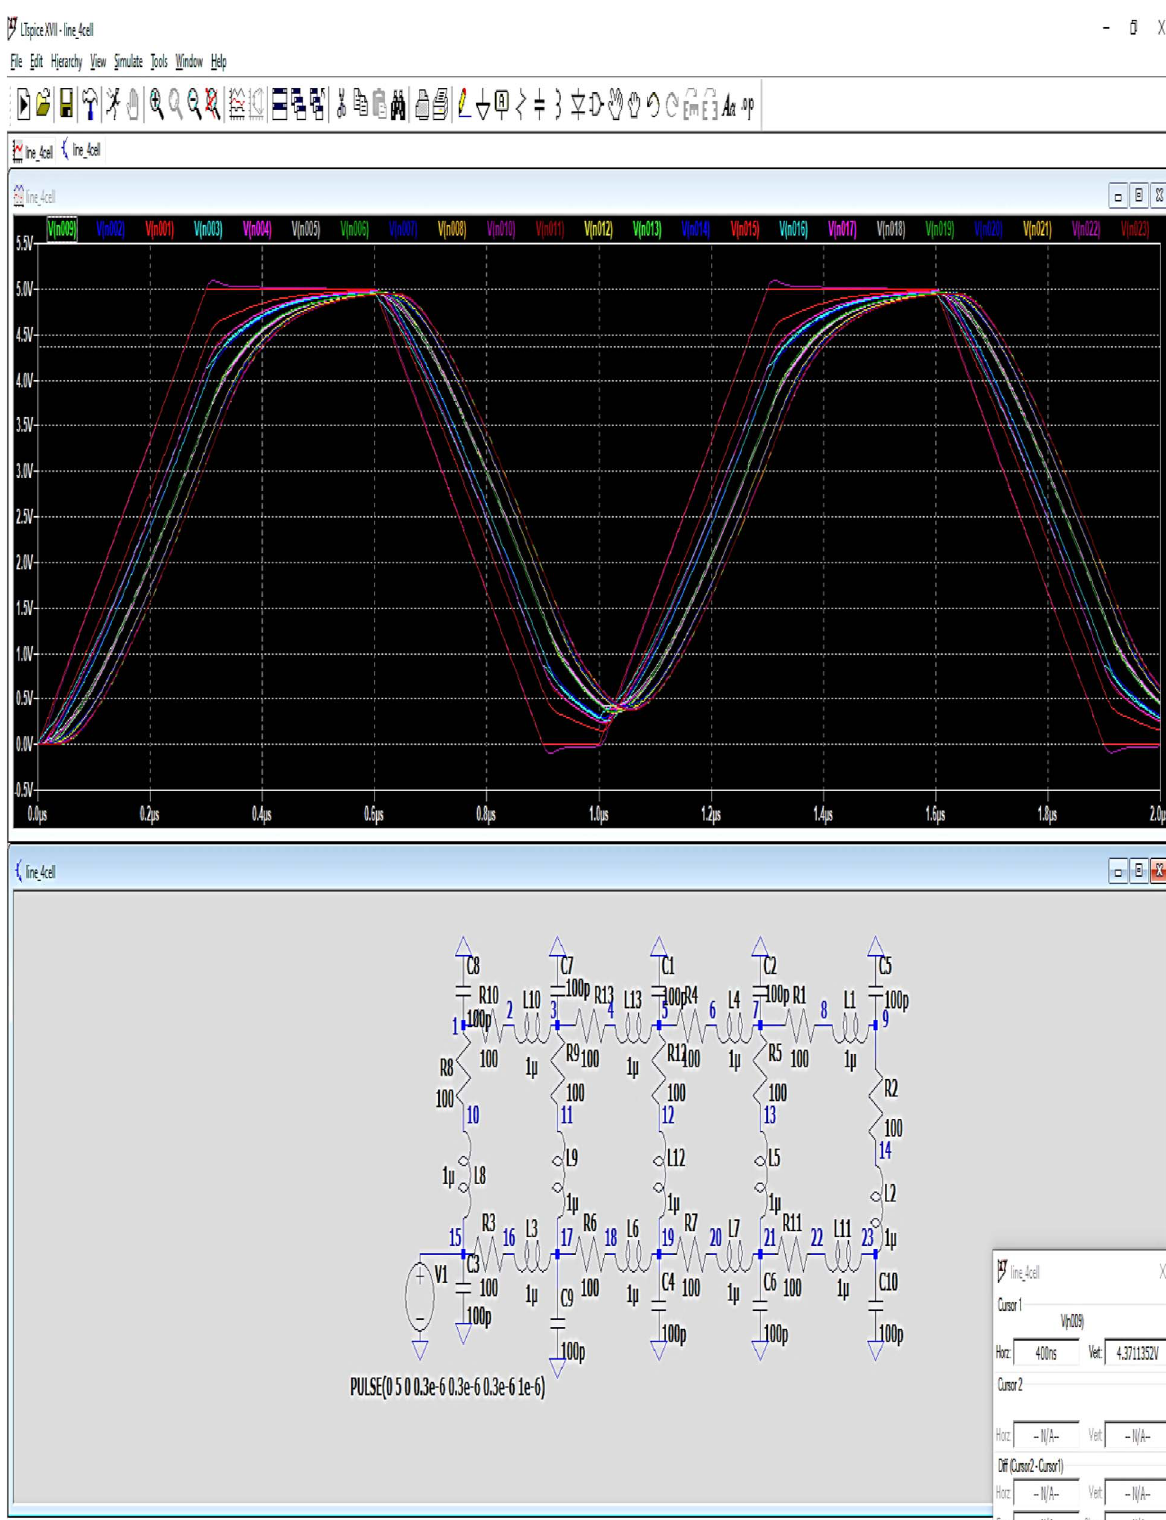
Figure 9. EES containing 23